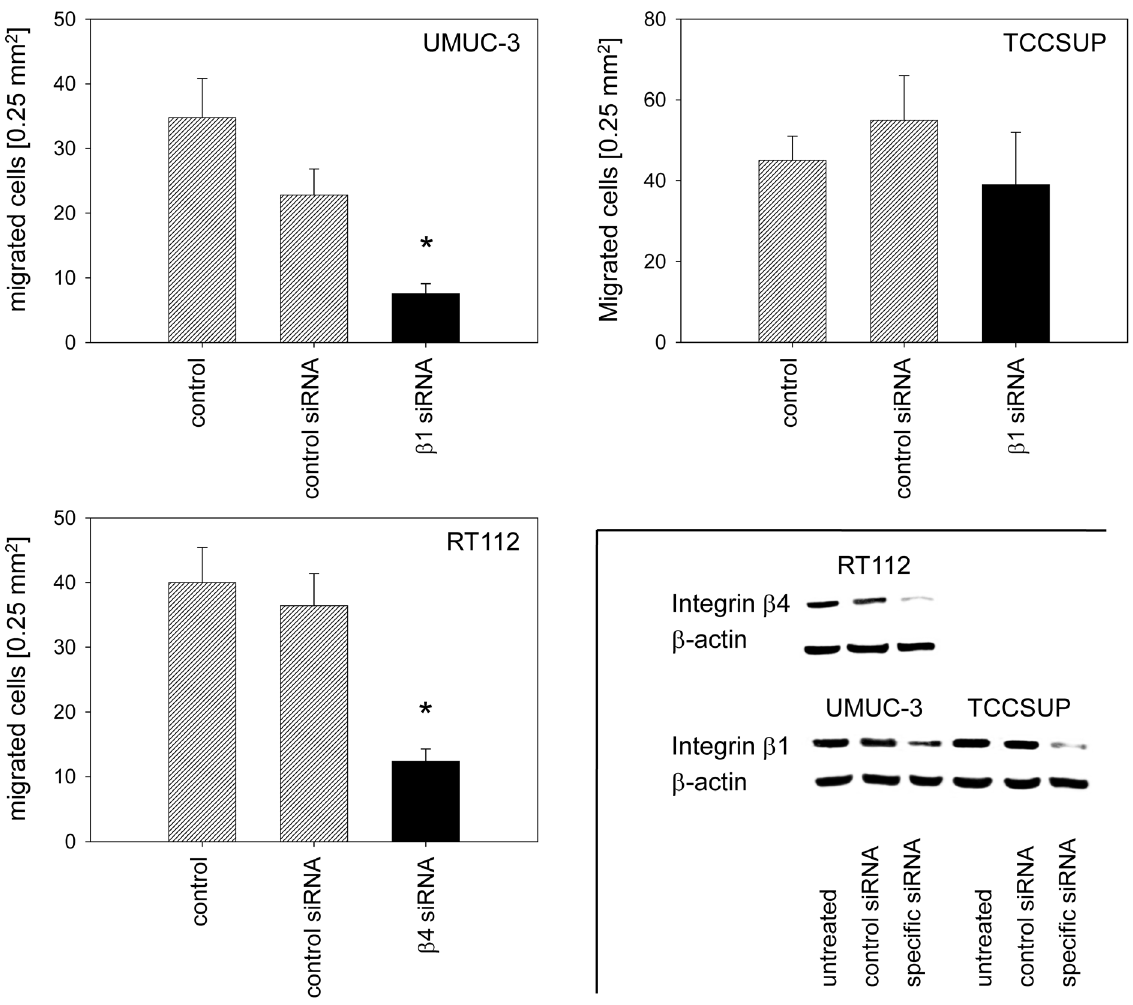
Figure 9. Knock-down of b 1 (UMUC-3, TCCSUP) or b 4 (RT112) integrin alters chemotaxis. Tumor cells were transfected with integrin b 1 or b 4 siRNA or scrambled siRNA (siRNA control). Controls remained untreated (control). Values are shown as migrated cells per 0.25 mm 2 . One representative of six experiments is shown. * indicates significant difference to the untreated control. Insert taken from figure 8.